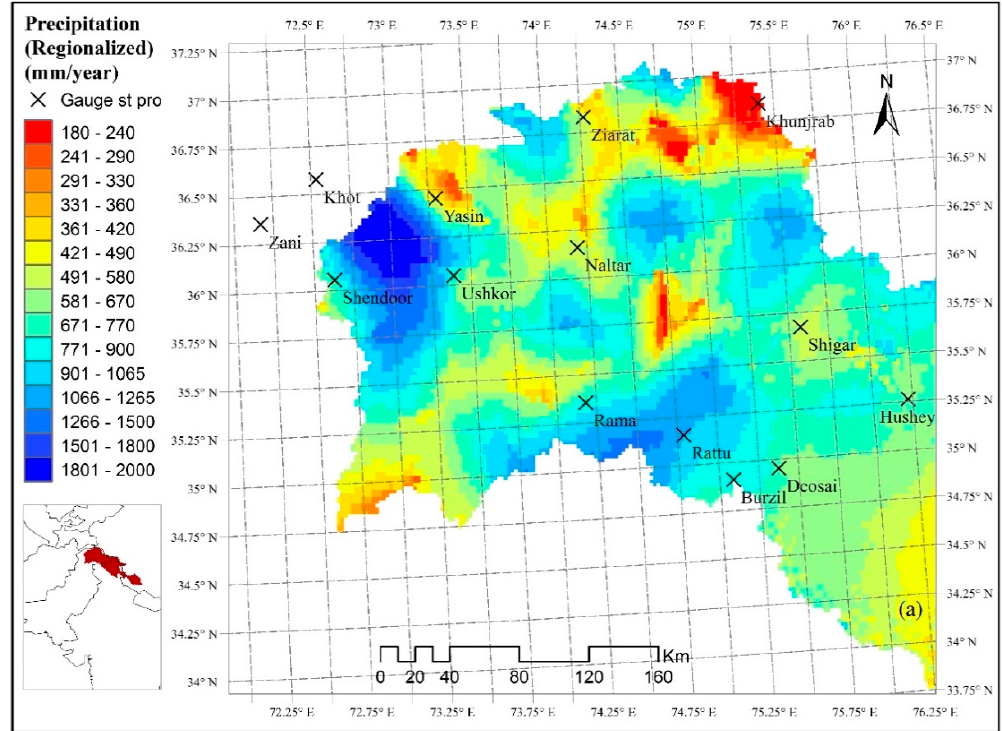
Figure A1. Spatial precipitation regimes in the UIB (adopted from Khan and Koch unpublished). Climate 2018 , 6 , x FOR PEER REVIEW